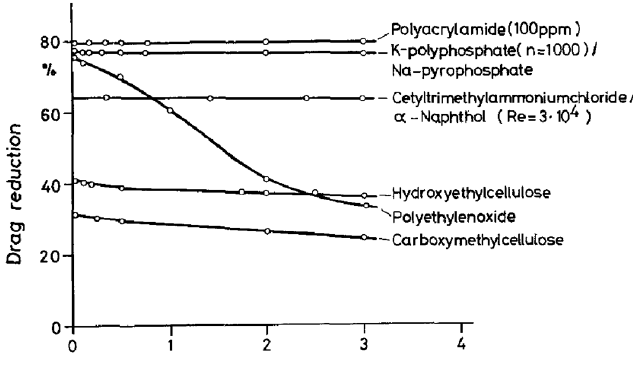
Figure 12. Effectiveness of various flow enhancers at a concentration of 300 ppm in water as a function of the circulation time at Re = 10 5 and d = 14 mm, reprinted with permission from [88]. Copyright Springer, 1985.